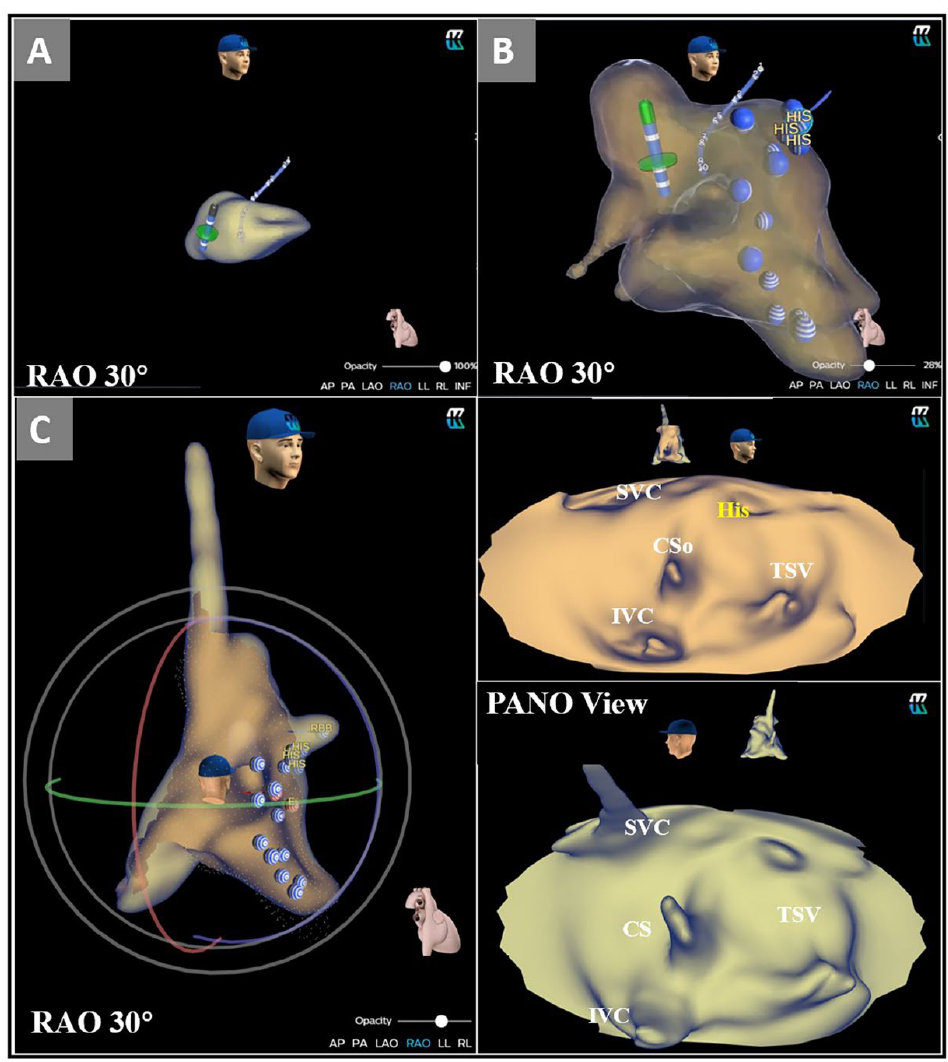
Figure 1. Stepwise approach to determine the para-SP region in PANO View. ( A ) The ablation catheter was advanced into the heart, and an instant image of the right atrium was created; ( B ) More details of anatomical landmarks in the right atrium were acquired; ( C ): The RAO in was chosen in the 3D reconstruction model, the heart was opened in PANO View, and the cutting line was adjusted to ensure a clear view of the para-SP region. ABL = ablation catheter; CS = coronary sinus, CSo = coronary sinus ostium; His= His bundle electrogram; IVC = inferior vena cava; LAO = left anterior oblique; PANO View = Panoramic View; RAO = right anterior oblique; SP = slow pathway; TA = tricuspid annulus.